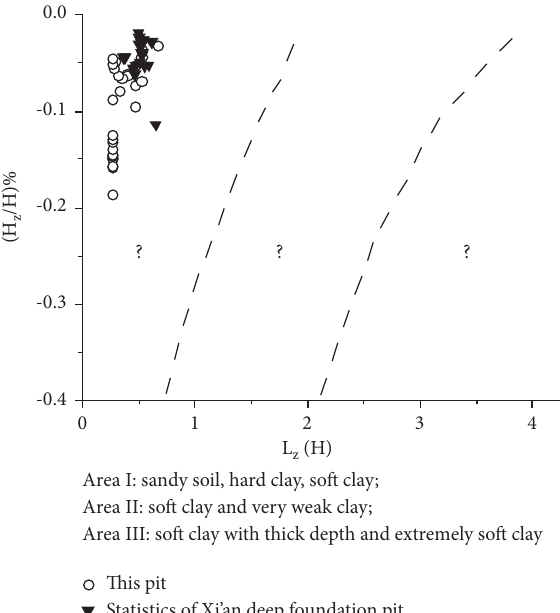
Figure 13: Ground settlement caused by excavation of foundation pit.